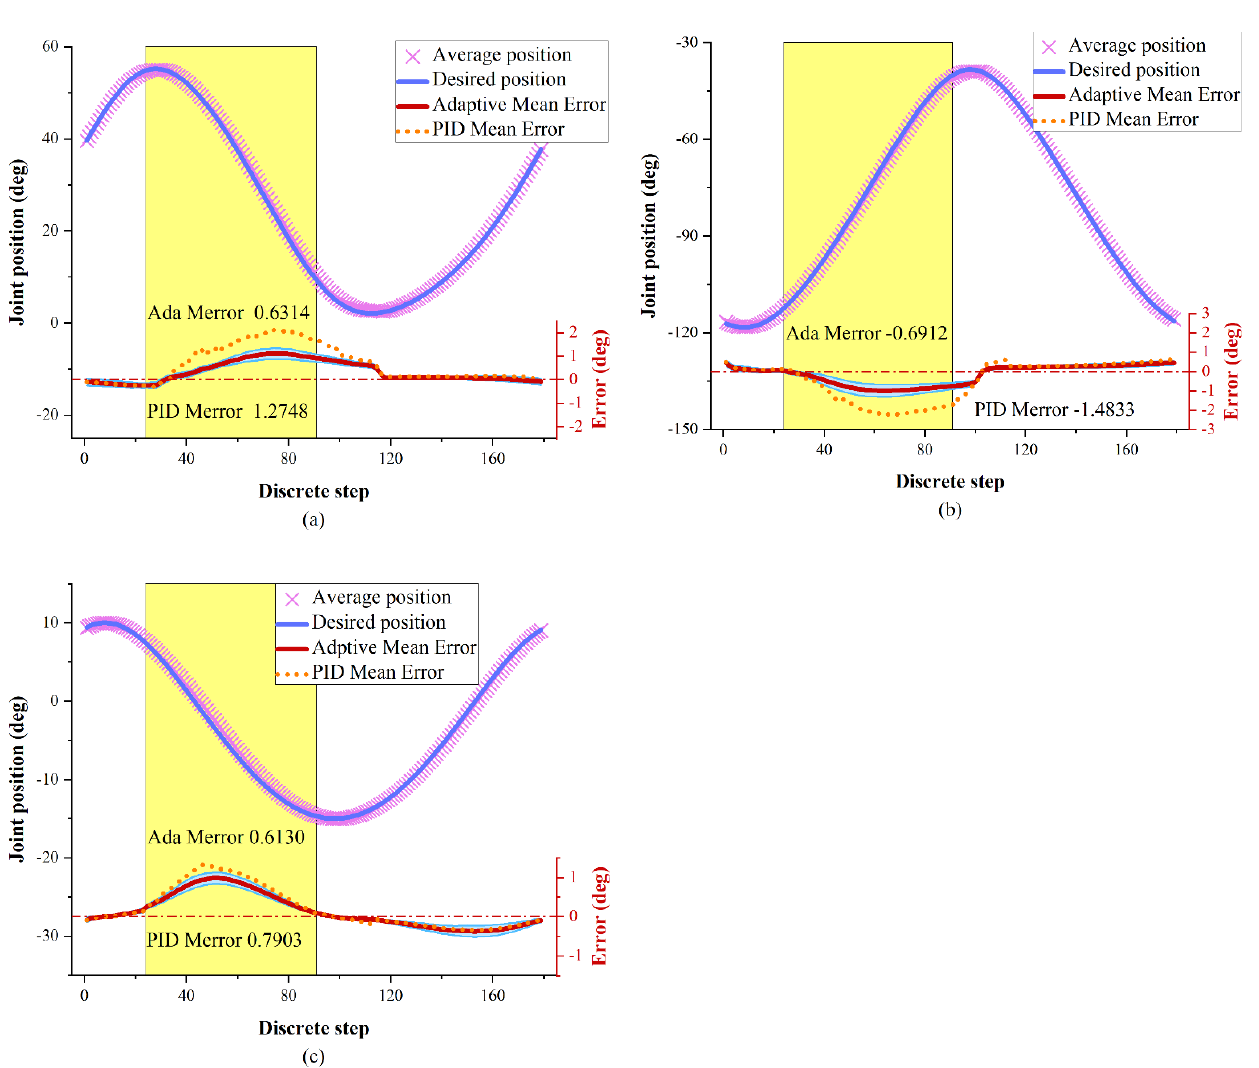
Figure 7. Tracking performances of ( a ) joint q 1 , ( b ) joint q 2 and ( c ) joint q 3 . The joints are affected by interaction forces around yellow areas (AZ). Average error (red line) and error bars (blue area) are plotted based on standard deviations from 20 group data .